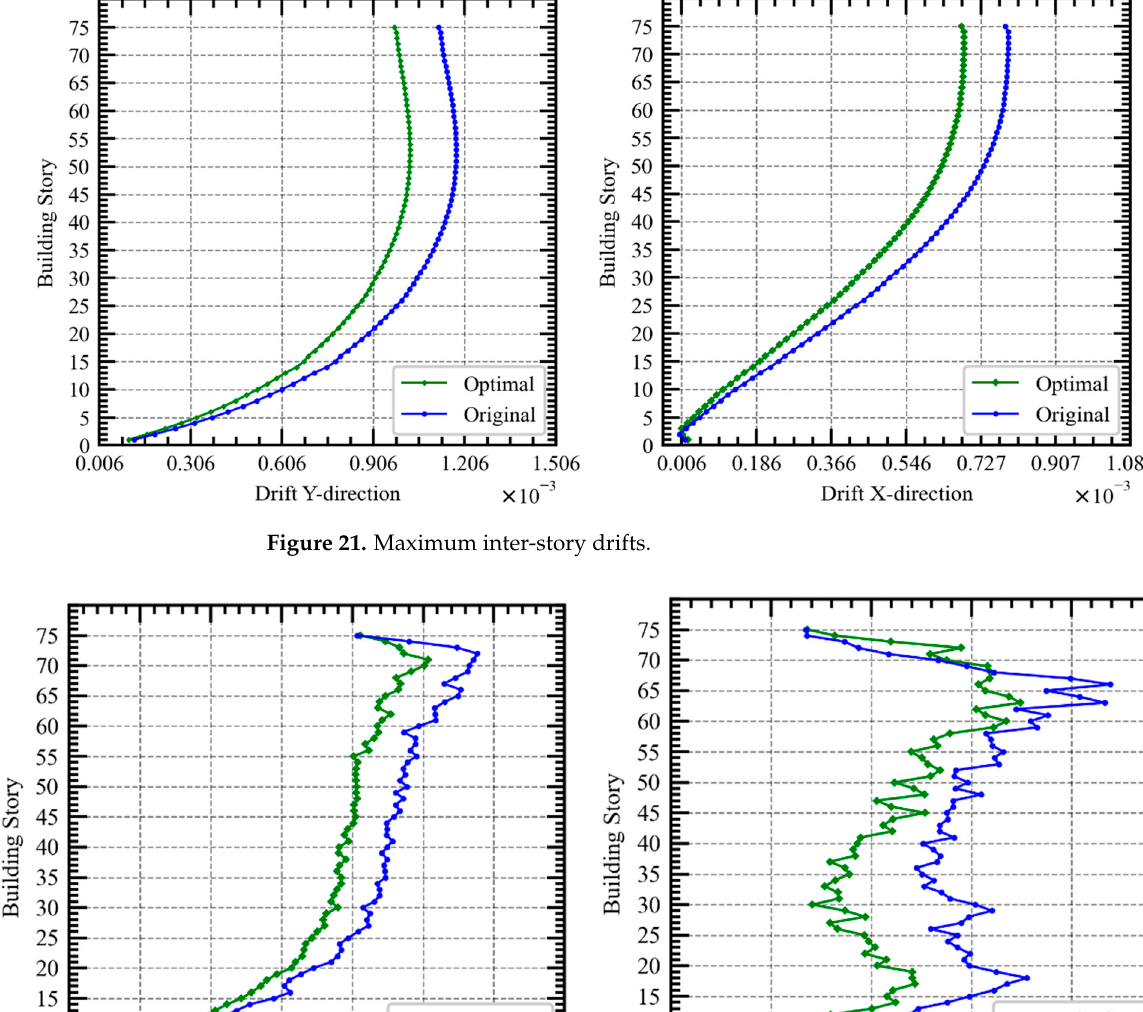
Figure 21. Maximum inter-story drifts.